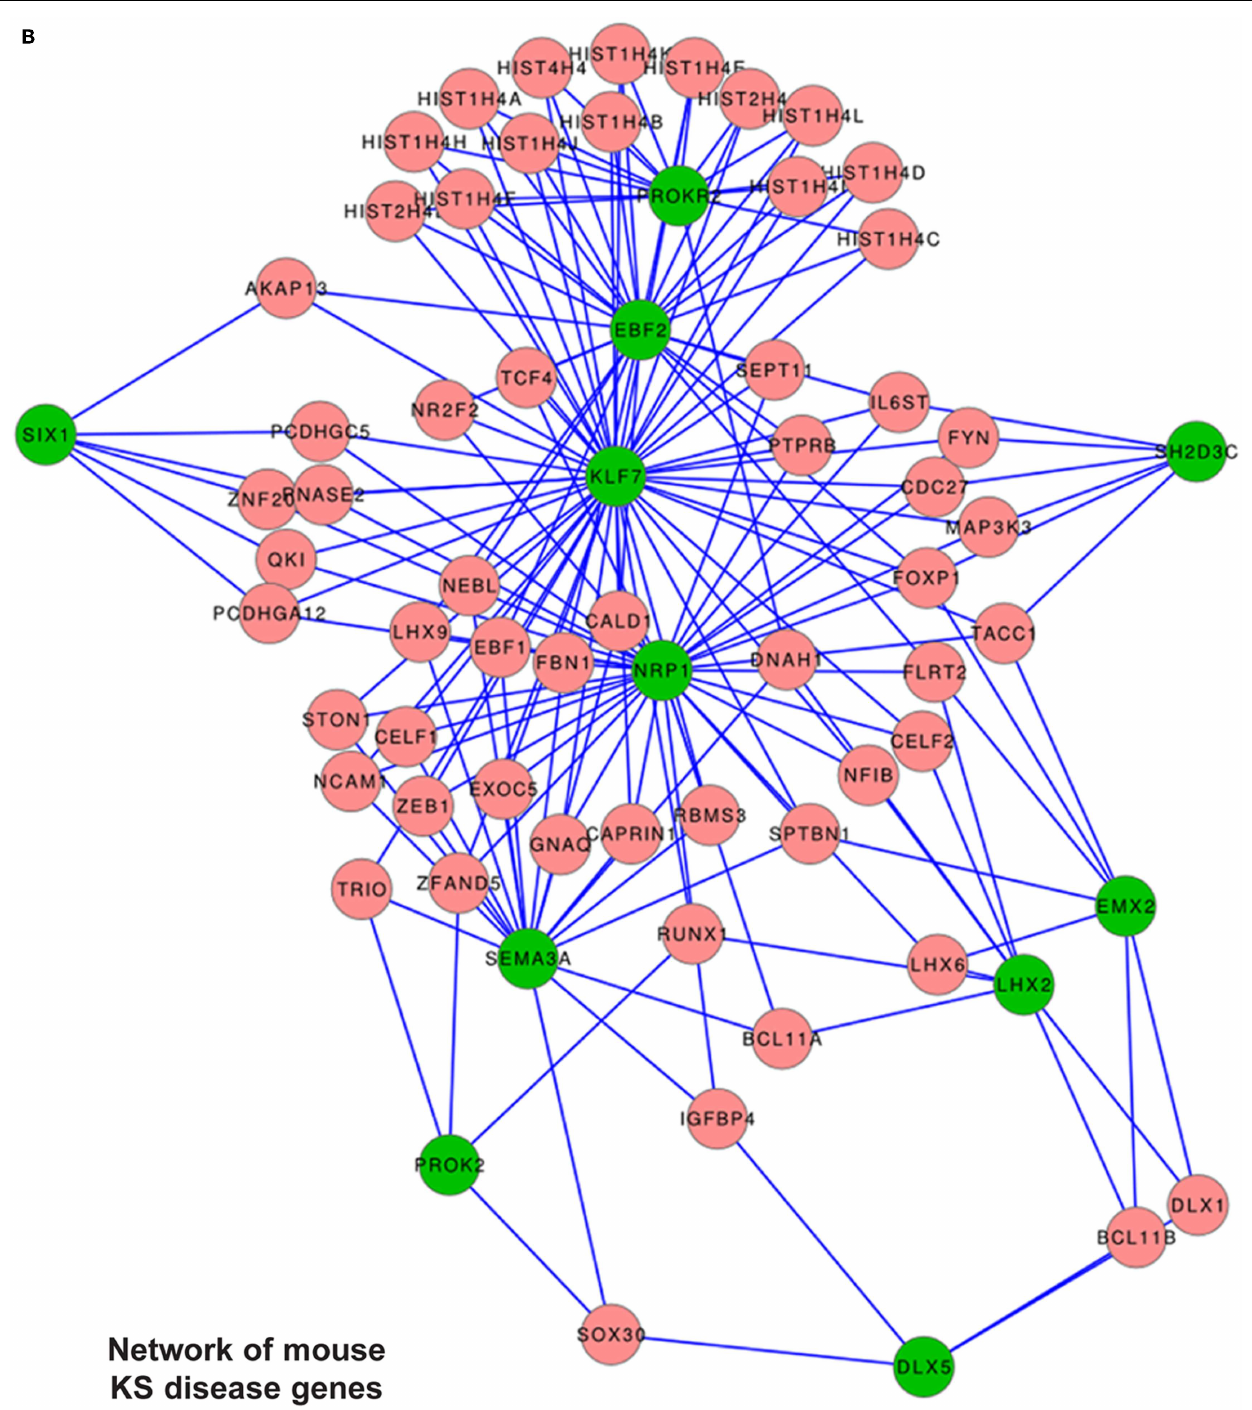
these analyses are in the text. For simplicity, only the genes connected with at least three input genes are shown; the genes connected with “at least one” or “at least two” input genes are available upon request. Green circles represent the input genes, pink circles represent the connected genes, lines represent statistically significant